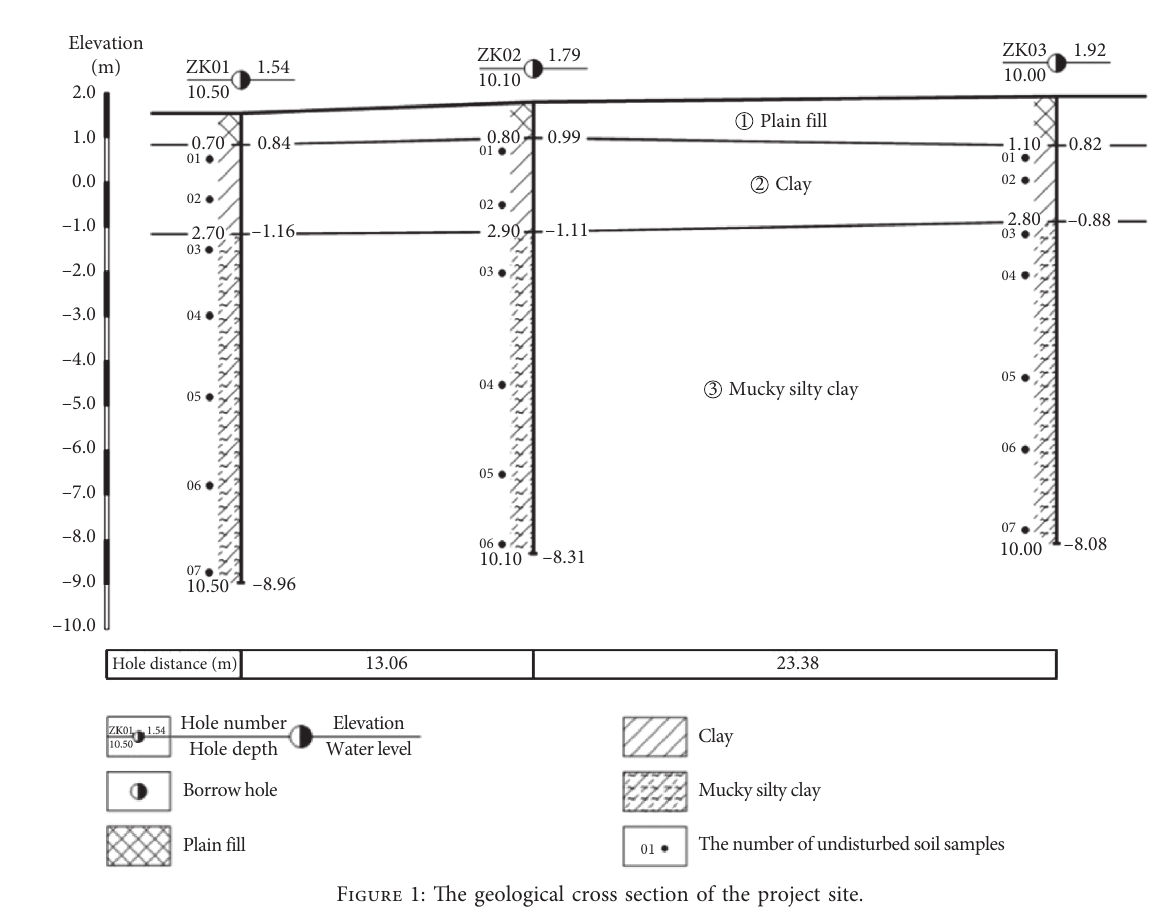
Figure 1: The geological cross section of the project site.